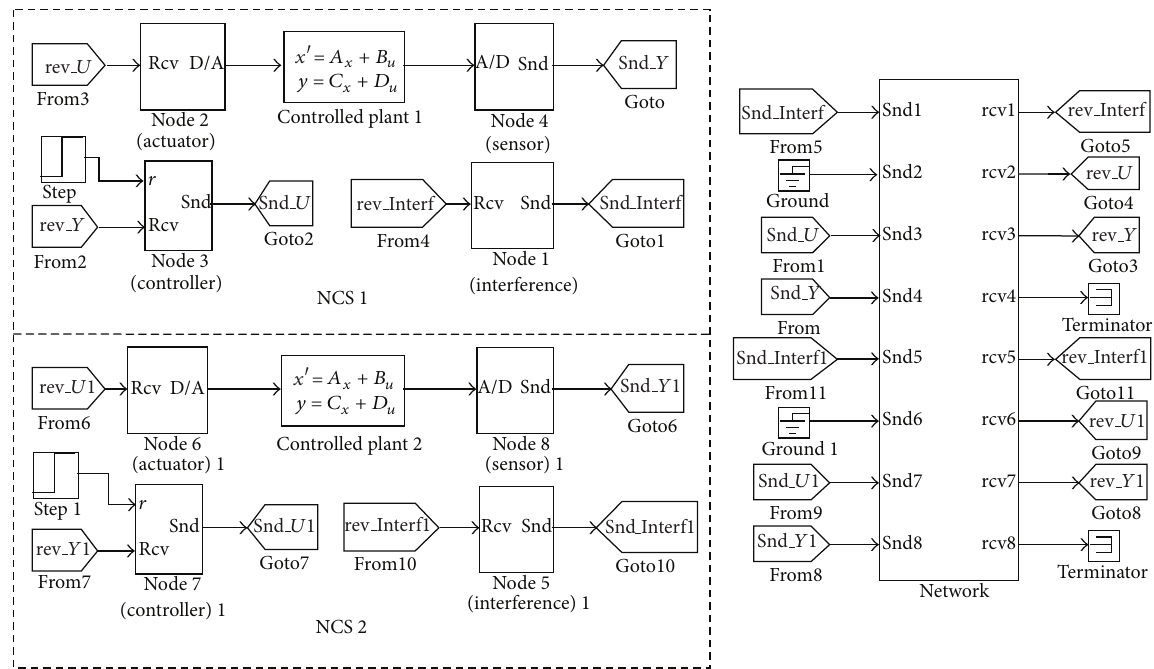
Figure 8: Two independent NCSs based on one 100M switch.